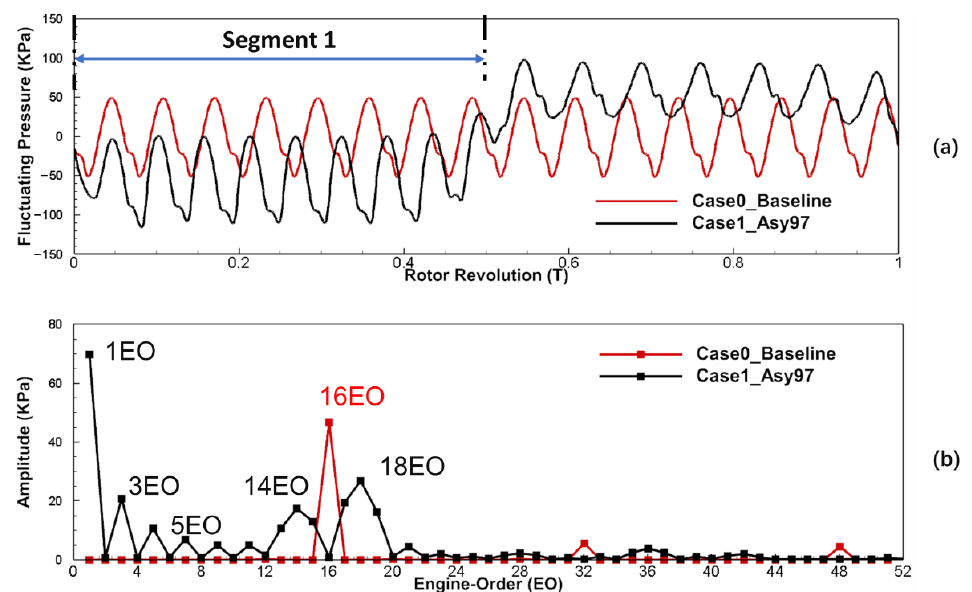
Figure 9. ( a ) Time histories of the fluctuating pressure at monitoring point P; ( b ) Frequency spectra of fluctuating pressure at monitoring point P.